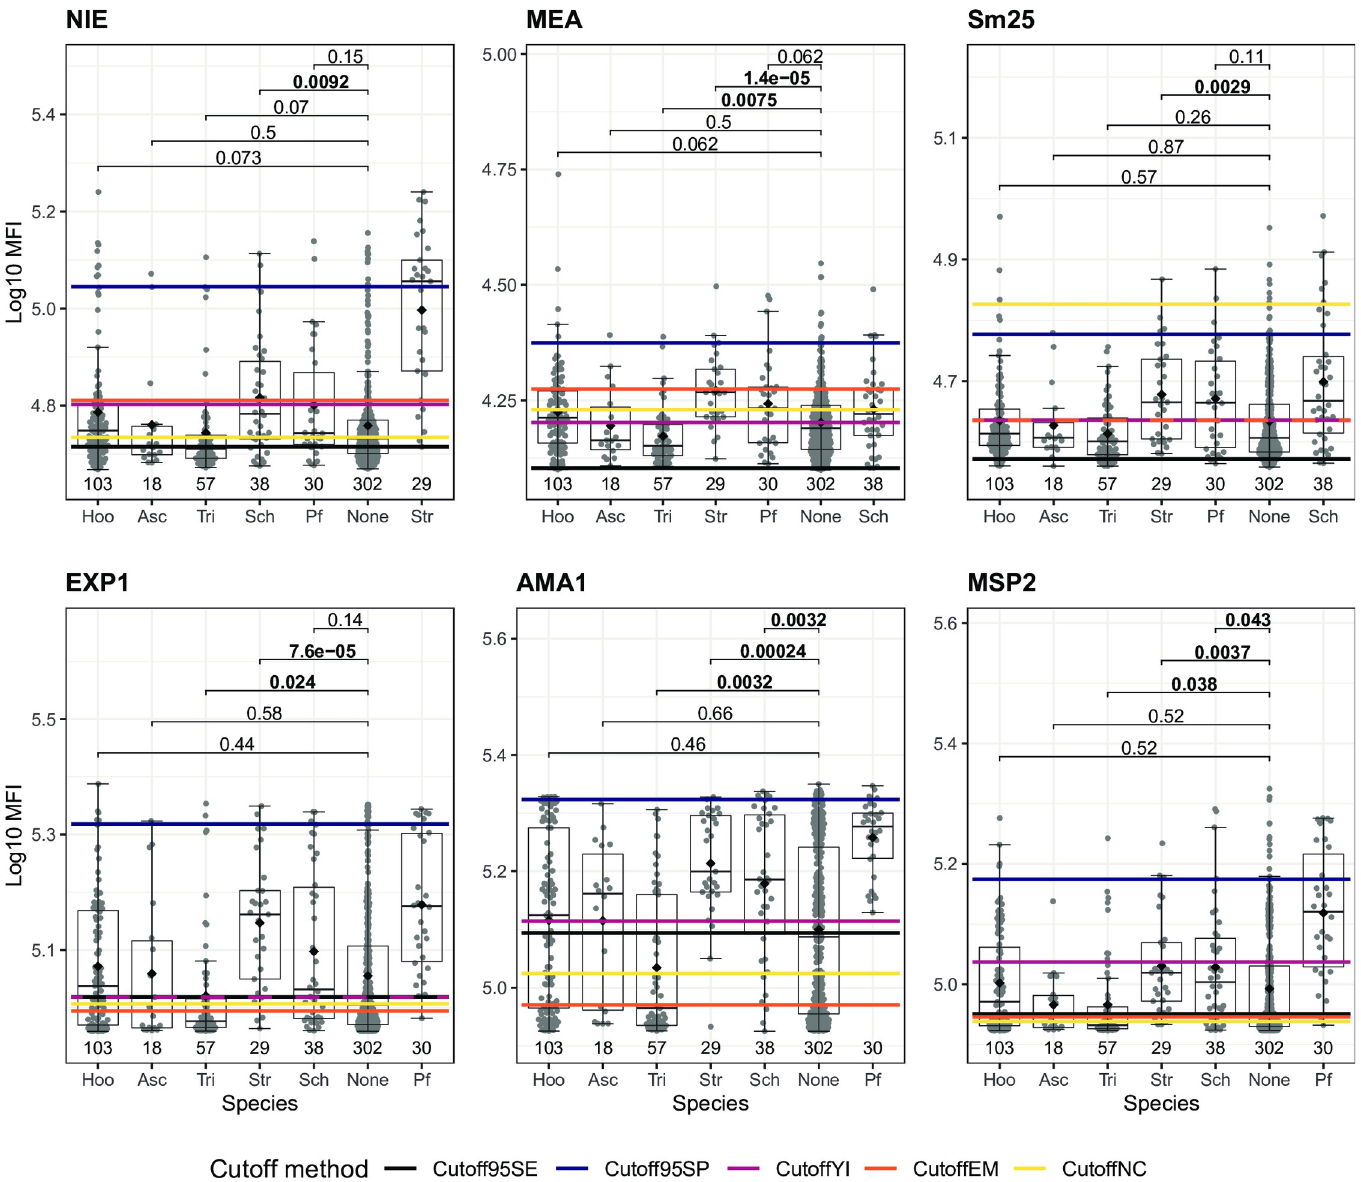
Fig 8. Effect of single infections on IgG levels to other infections. Only individuals with single infections or no infections at all detected by the combination of microscopy and qPCR are shown. Antibody levels are presented as the log 10 -transformed median fluorescence intensity (MFI) of IgG against Strongyloides stercoralis (NIE), Schistosoma spp. (Sm25 and MEA) and P . falciparum (EXP1, AMA1 and MSP2) antigens. For each antigen, antibody levels for each species were compared to the levels of those with no infection and the corresponding species to the antigen was shown as a reference. Statistical comparison between groups was performed by Wilcoxon rank-sum test and the adjusted P values by the Holm approach are shown. Statistically significant P values are highlighted in bold. The sample size of each group is shown below each boxplot. The boxplots represent the median (bold line), the mean (black diamond), the first and third quartiles (box) and the largest and smallest values within 1.5 times the interquartile range (whiskers). Data beyond the end of the whiskers are outliers. Cutoff95SE: cutoff prioritizing a minimum sensitivity of 95%; Cutoff95SP: cutoff prioritizing a minimum specificity of 95%; CutoffYI: cutoff corresponding to the maximum Youden’s Index; CutoffEM: cutoff defined by the Expectation- Maximization algorithm; CutoffNC: cutoff calculated as mean + 3 � standard deviations of the log 10 -transformed MFI levels from the non-endemic population. Asc: Ascaris spp.; Hoo: Hookworm; Tri: Trichuris spp.; Str: Strongyloides stercoralis ; Sch: Schistosoma spp. Hel: Helminths; Pf: Plasmodium falciparum . The rest of the antigens are in S4 and S5 Figs